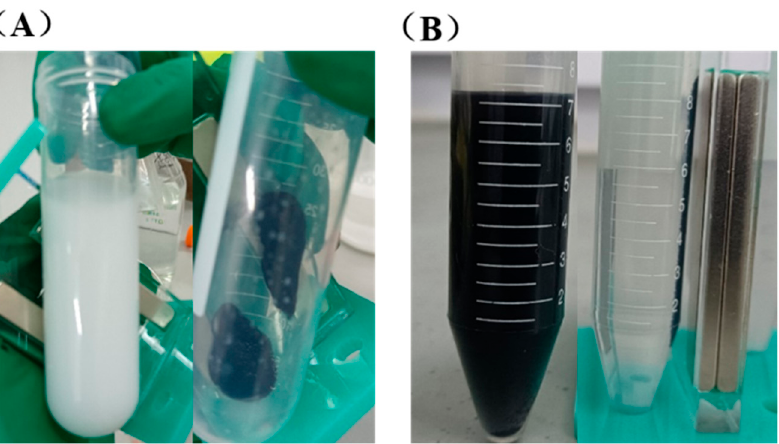
Figure 2. Photographs of magnetic nanomaterials before and after magnetic separation. ( A ) the mixing state (left) and the magnetic suction state (right) of Fe 3 O 4 @SiO 2 ; ( B ) the mixing state (left) and the magnetic suction state (right) of Aminated Fe 3 O 4 @SiO 2 .